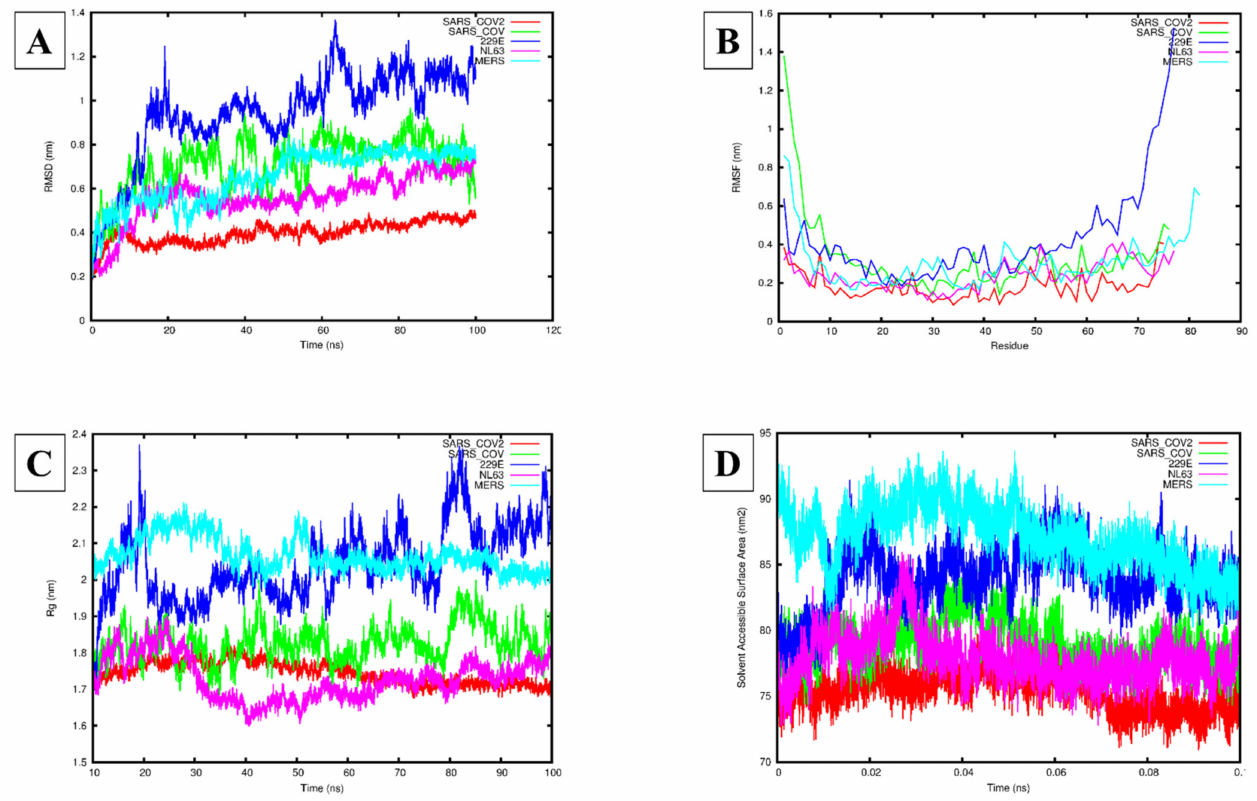
Figure 6. Molecular dynamics simulations of the human (h) coronavirus (CoV) envelope (E) proteins for SARS-CoV-1, -2, MERS-CoV, HCoV-229E, and HCoV-NL63. ( A ) The root mean square deviation (RMSD) (nm) of each of the modelled hCoV E proteins over 100 ns. ( B ) The root mean square fluctuation (RMSF) (nm) of each residue for the modelled hCoV E proteins. ( C ) The radius of gyration (Rg) (nm) of each of the modelled hCoV E proteins over 100 ns. ( D ) The solvent-accessible surface area (SASA) (nm 2 ) of each of the modelled hCoV E proteins over 0.1 ns. Red: SARS-CoV-2 E protein, Green: SARS-CoV-1 E protein, Blue: HCoV-229E E protein, Pink: HCoV-NL63 E protein, Cyan: MERS-CoV E